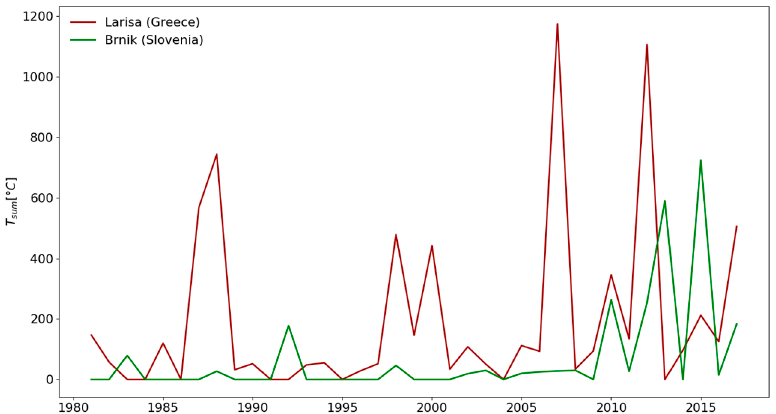
Figure 3. The heat waves’ temperature sums (above the threshold) for the period 1981–2017 in Brnik (Slovenia) and Larisa (Greece).